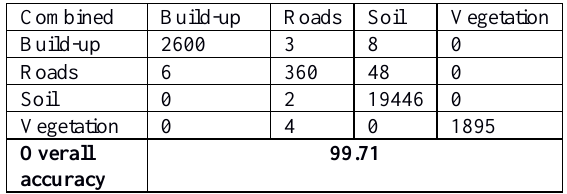
Overall accuracy of image classifications is presented in Tables 1 to 4. Images are classified by four materials including build-up, roads, soil and vegetation regions to evaluate performance of three image classification methods. RF, SVM and ML classification methods have overall accuracies of 99.83, 99.93 and 99.7 percent respectively for the evaluation dataset.